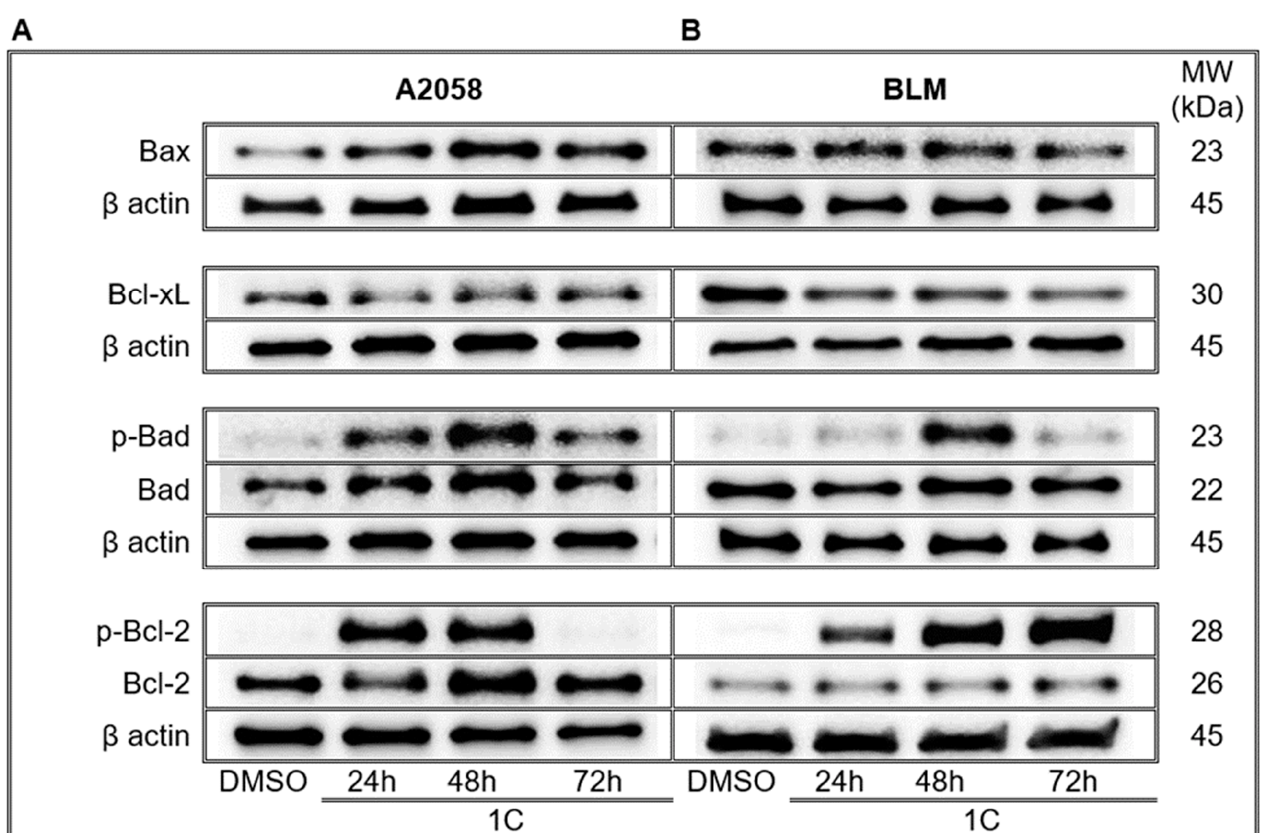
Figure 7. Western blot analysis of mitochondrial apoptosis-related proteins in A2058 ( A ) and BLM ( B ) melanoma cells after treatment with chalcone 1C for 24, 48 and 72 h. Representative WB.